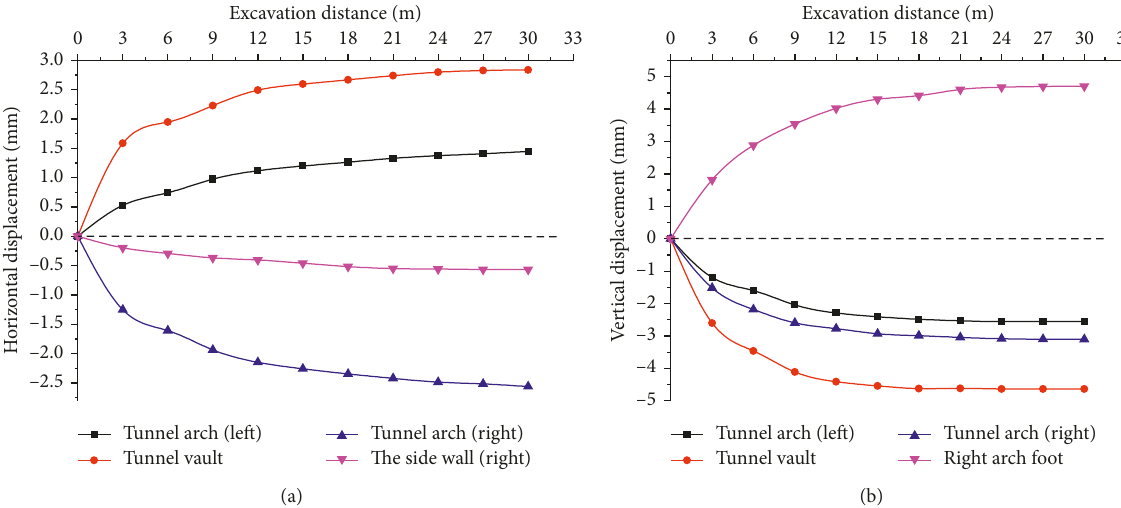
Figure 12: Displacement of surrounding rock of the tunnel under different working conditions: (a) horizontal displacement; (b) vertical